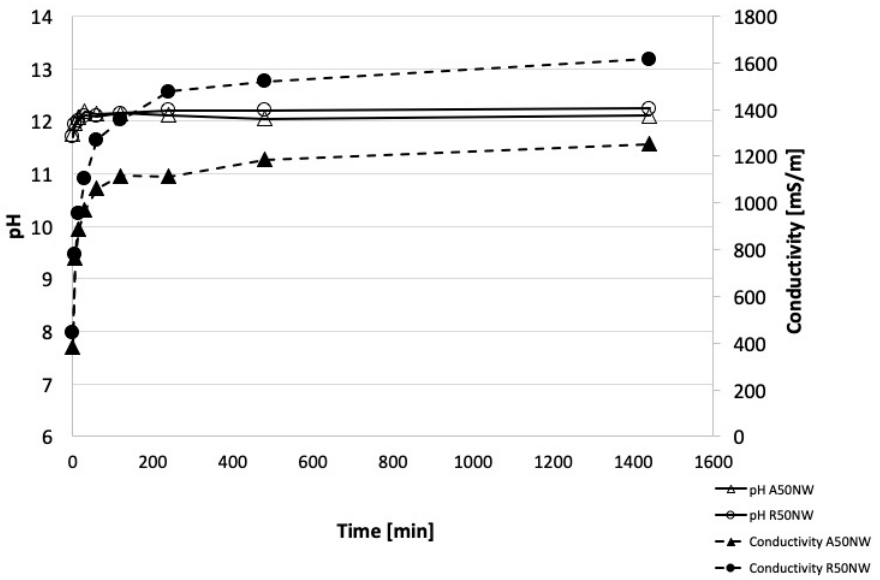
Figure 8. pH values of A50NW and R50NW AAMs (lines are drawn for eye help, only). The confidence interval for pH is about 1%, while for conductivity is around 2%.